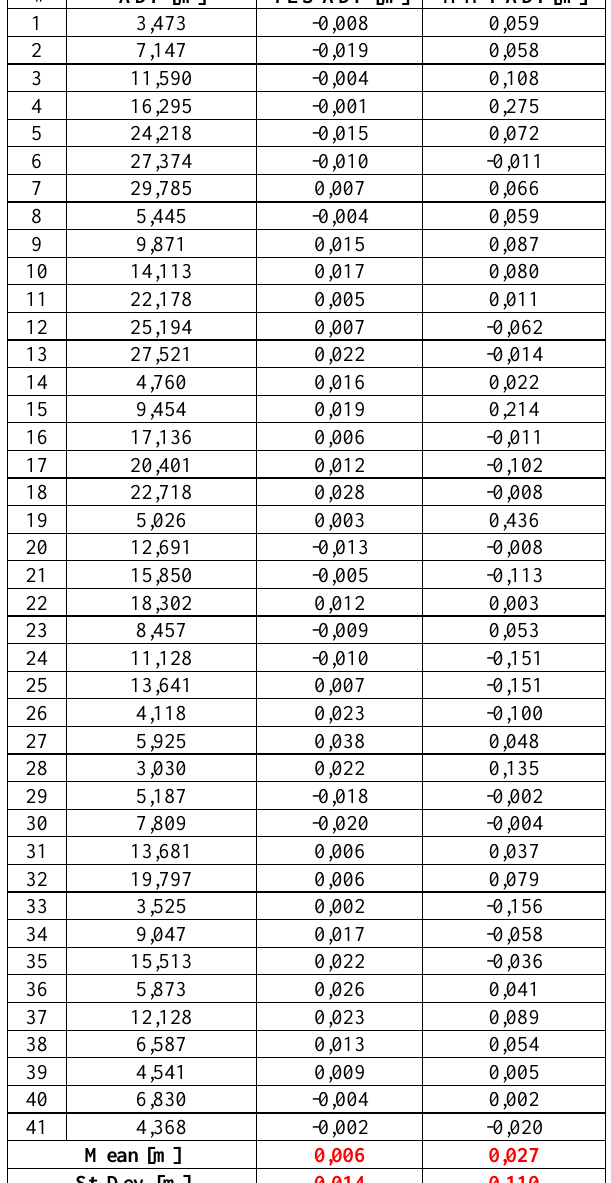
Table 6. Distance residuals